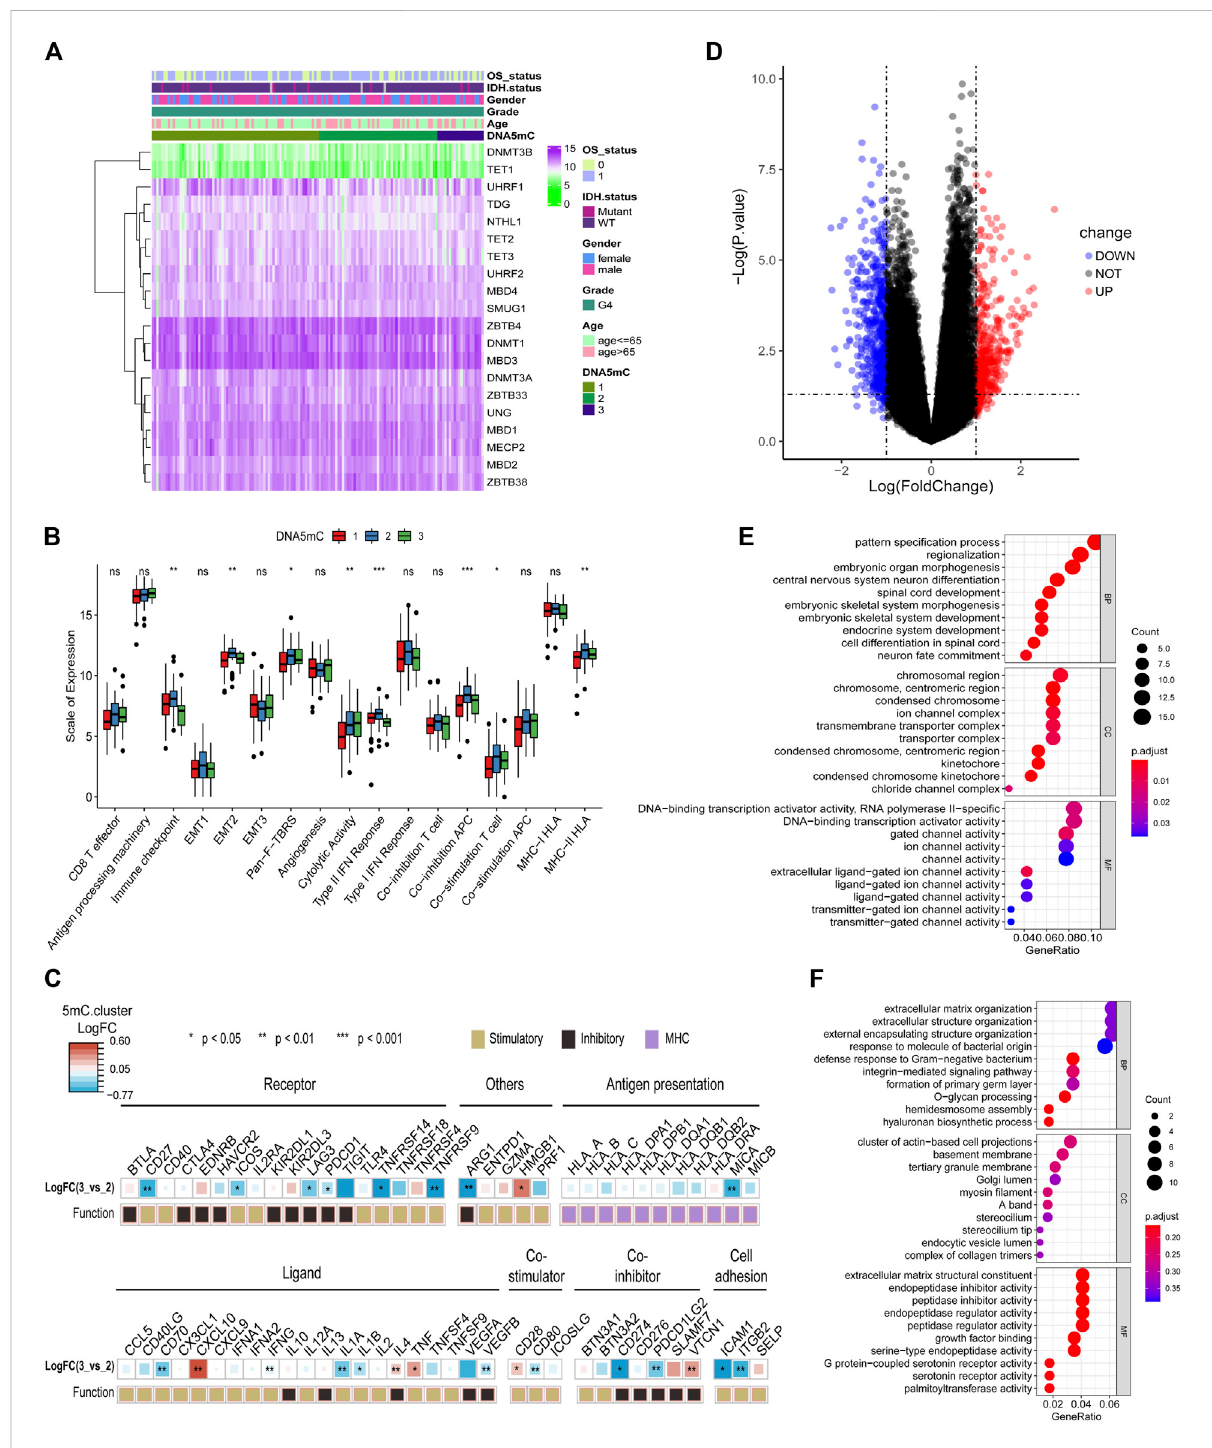
FIGURE 5 Tumor DNA5mC subtypes differ in the expression of immune-related factors. (A) Heatmap displaying the expression pro fi les of 20 DNA5mC genes. (B) Different immune-related factors subsets among three DNA5mC subsets. (C) A difference between DNA5mC-2 and -3 subtypes in immune-related factors. (D) Differential expression analysis between DNA5mC-2 and -3. (E – F) Down-regulated and up-regulated DEGs enriched with GO terms.